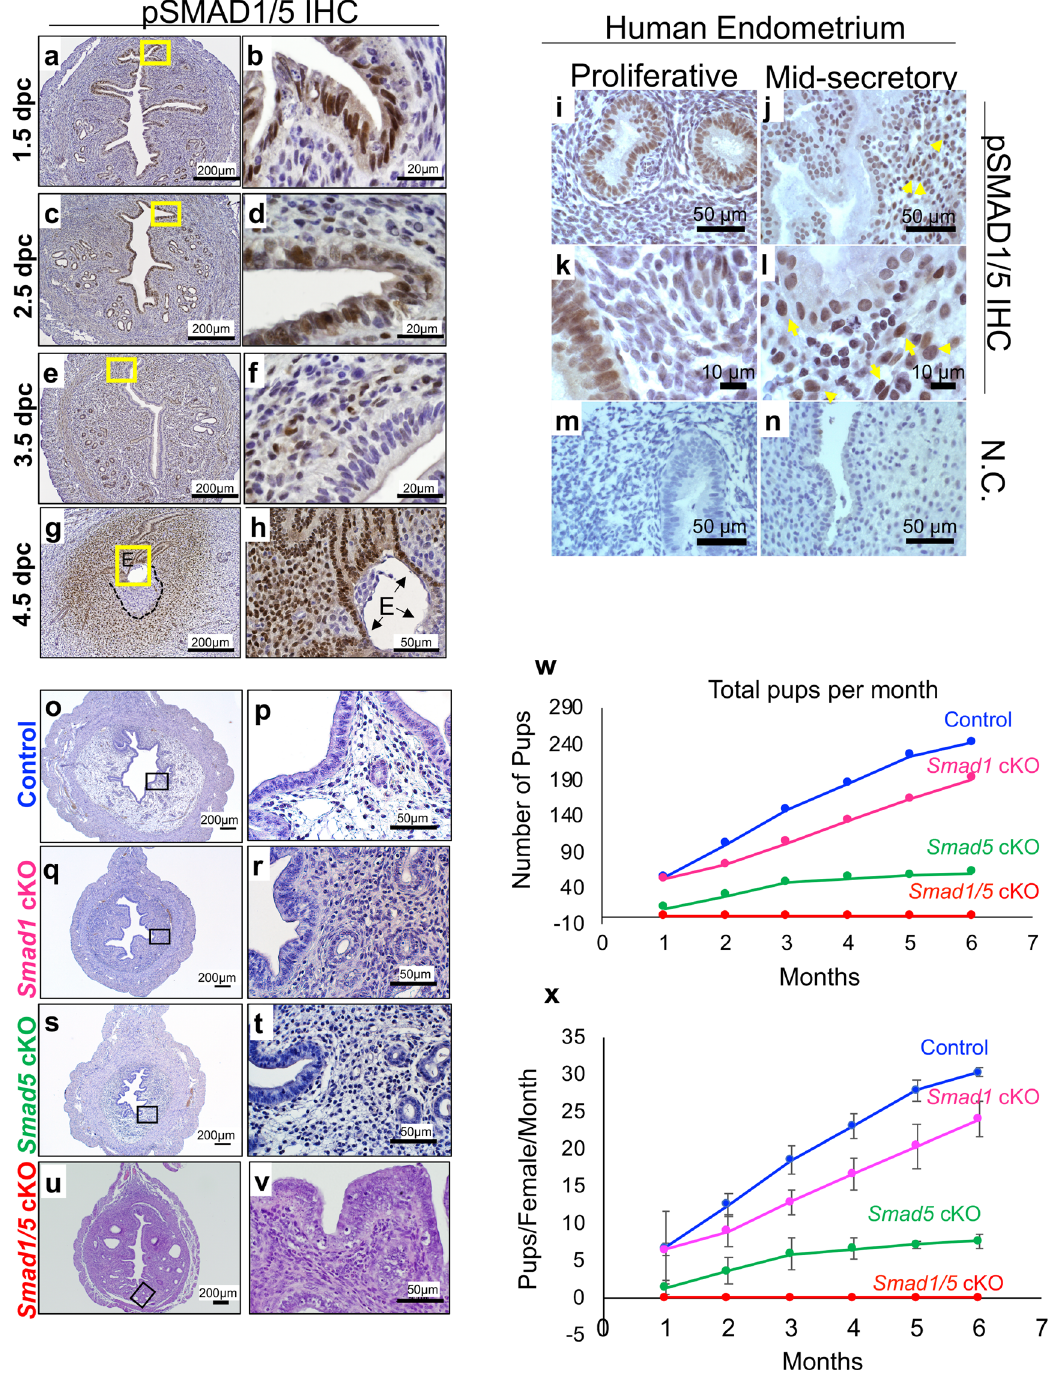
Fig. 1 Conditional deletion of SMAD1/5 results in female infertility. a – h pSMAD1/5 immunohistochemistry (IHC) at 1.5 dpc a – b , 2.5 dpc c – d , 3.5 dpc e – f , and 4.5 dpc (black dotted lines indicate primary decidual zone) g – h . E , embryo. Representative image of the embryo, observed in at least three specimens from different mice. Images in a – h represent fi ndings observed in at least three individual samples per pregnancy timepoint. i – n pSMAD1/5 IHC in human endometrial biopsies obtained during the proliferative phase I , k or mid-secretory j , l of the menstrual cycle. m , n are negative controls, yellow arrows in j , l point to positive decidualized cells in the mid-secretory phase endometrium. Images shown are representative of patterns observed in three proliferative phase and six mid-secretory phase individuals. o – v H&E-stained uterine cross-sections from 12-week-old control o – p , Smad1 cKO q – r , Smad5 cKO s – t, and Smad1/5 cKO u – v mice. w – x Fertility assessment in Control ( n = 8), Smad1 cKO ( n = 8), Smad5 cKO ( n = 8), and Smad1/5 cKO ( n = 8) mice over the course of 6 months. Total pups per month are plotted in w , whereas the number of pups per female per month is plotted in x . Plotted as average pups per female per month ± standard error of the mean (SEM), n = 8 per genotype.